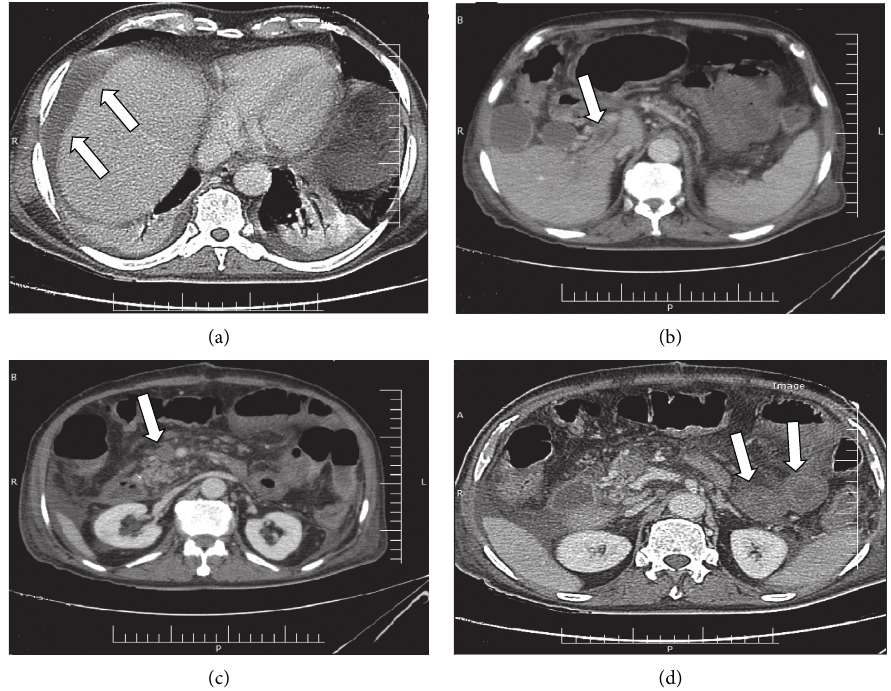
Figure 2: The patient’s CT: (a) ascites in chest CT; (b) portal vein thrombosis in abdominal CT; (c) extension of thrombosis in the superior mesenteric vein in abdominal CT; (d) edematous small bowel wall in abdominal